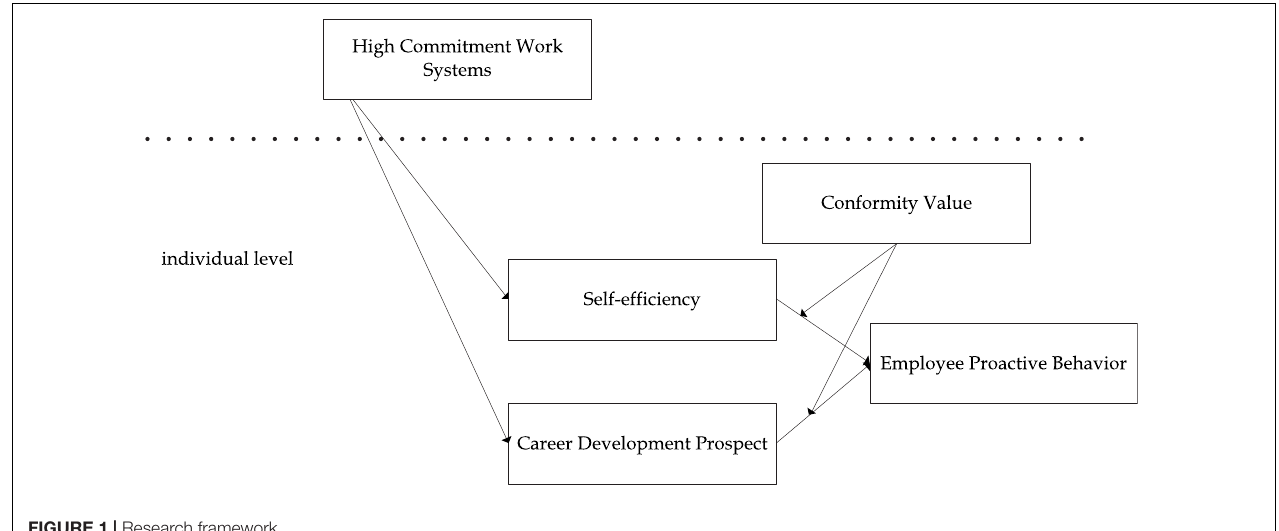
FIGURE 1 | Research